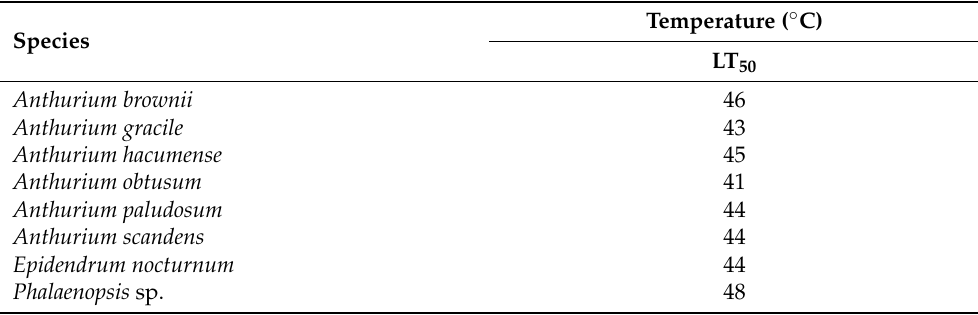
Figure 3. Viability of velamentous roots of eight species following heat treatments at 22, 42, 48, 51, 54 and 100 ◦ C ( A ). Measurements were obtained immediately after every heat treatment. For species names, see Appendix B. The absorbance of Triphenylformazan (TF, reduced form of TTC) per gram of dry weight (DW) was measured at 520 nm (expressed as A 520 g − 1 DW ). The 22 ◦ C and 100 ◦ C treatments were implemented as controls. Root tissue recovery was analyzed over five days ( B ). Data are means of three individuals per heat treatment. Table 3. Estimated temperature when roots lose 50% viability (LT 50 ). Results were obtained from viability measurements on roots tested immediately after every heat treatment. Temperature estimates were calculated with logarithmic equations describing the dependence of viability on the temperature of the heat treatments (from 22 to 100 ◦